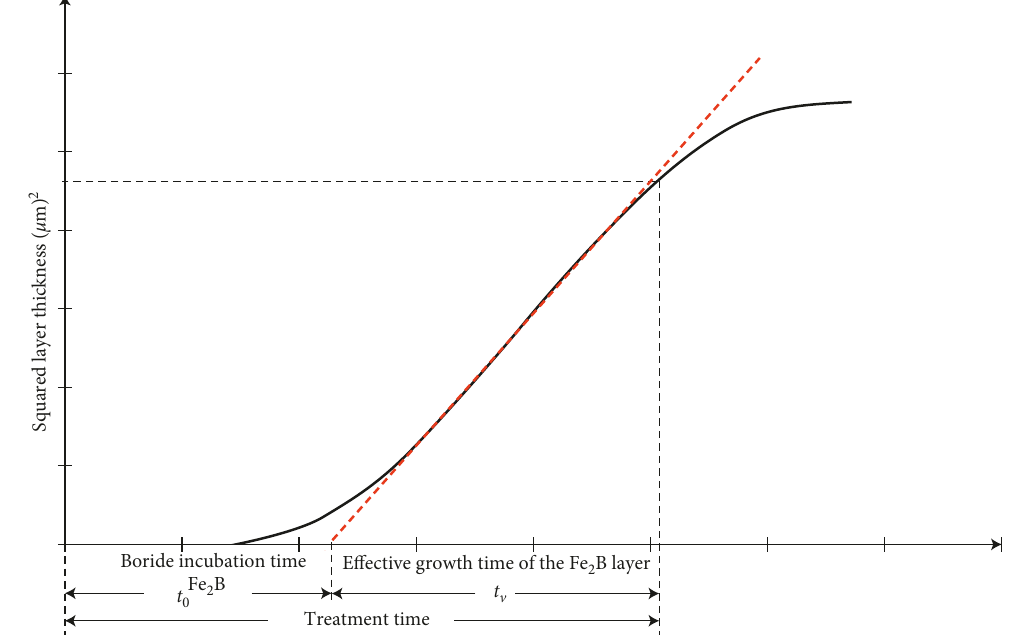
Figure 1: A schematic diagram of the parabolic growth law of Fe